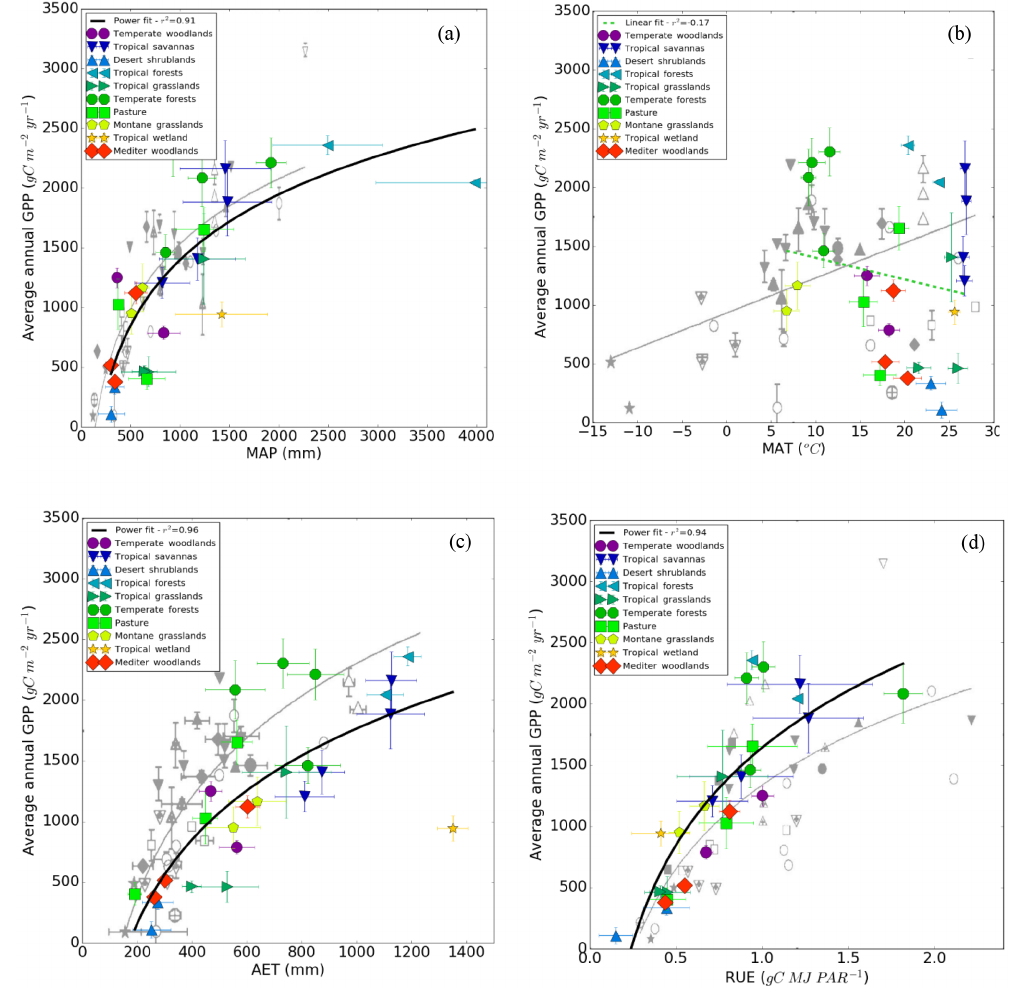
Figure 6. The relationships of Australian OzFlux tower data by ecoregion type (Table 1) between gross primary production (GPP) and the major climate drivers (a) mean annual precipitation (MAP) and (b) mean annual temperature (MAT). Also shown is the relationship between GPP and (c) actual evapotranspiration (AET) and (d) radiation-use efficiency (RUE). The global relationships in Garbulsky et al. (2010) are shown in the background to aid comparison. Simple curve fits are shown to aid